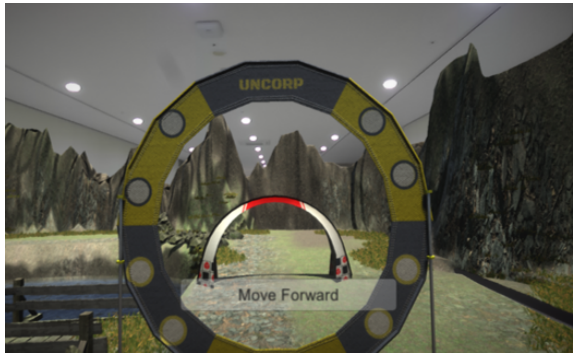
Figure 13. Instructional text displayed on the HMD of a drone